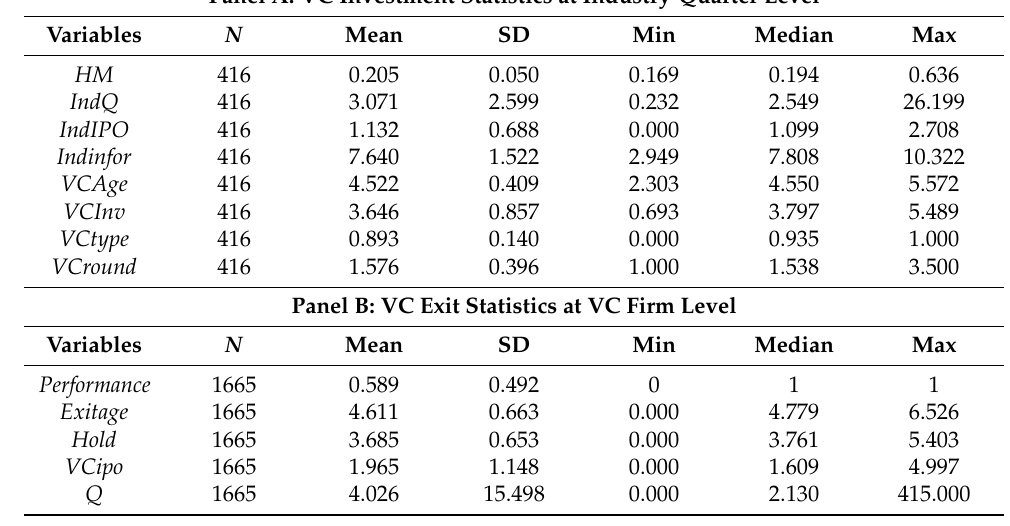
Table 1. Summary statistics for the main